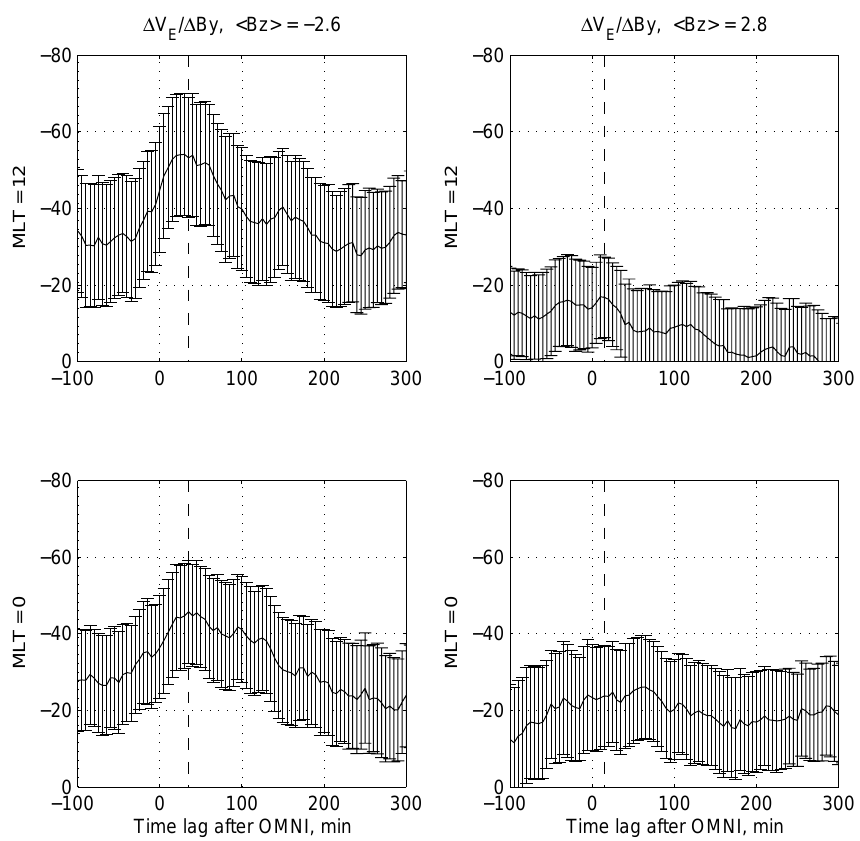
Fig. 1. The regression coefficients against the lag time for southward (left) and northward (right) IMF. Top and bottom panels correspond to the day and night side, respectively. Vertical lines indicate the lag times 35min and